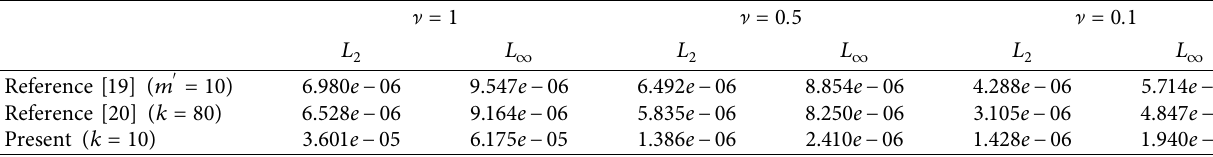
Figure 1: Te best value of shape parameter c for Example 1 at T � 0 . 1 with h � 0 . 0005, k � 10, and ] � 0 . 1. Table 1: Error norms of Example 1 at T � 0 . 1 for h � 0 . 0005 and α � 0 . 5.